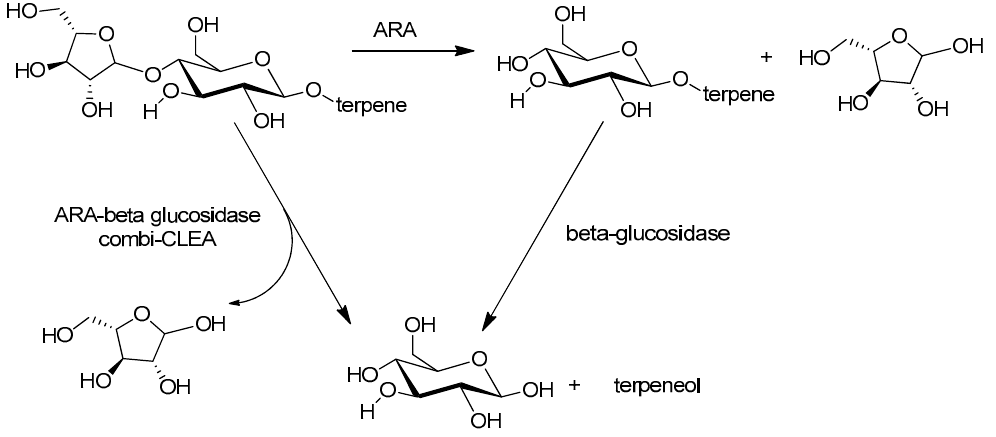
Figure 10. Wine aroma enhancement catalyzed by a combi-CLEA.